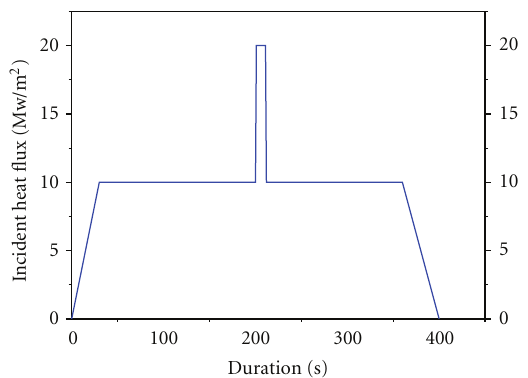
Figure 2: Incident heat flux on analyzed model.